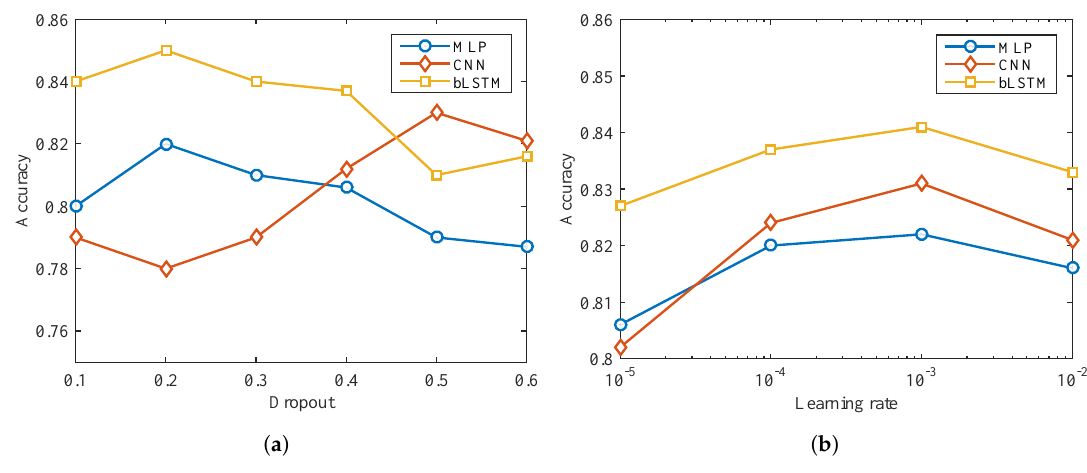
Figure 10. Dropout and learning rate optimization.